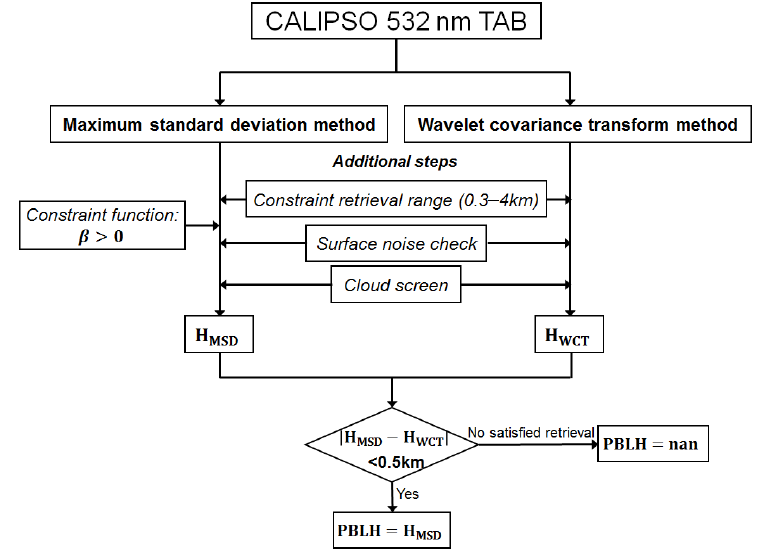
Figure 2. The schematic diagram of retrieving the PBLH from CALIPSO.